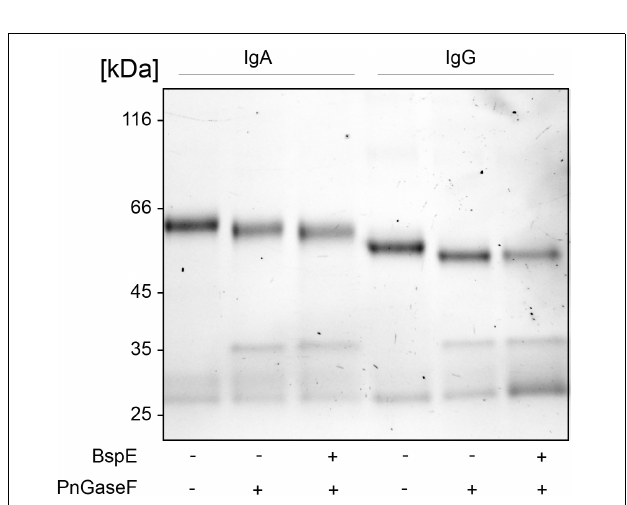
FIGURE 7 | Removal of N- glycosylation at position Asn 459 does not affect BspE hydrolysis of IgA. IgA control, IgA deglycosylated with PNGaseF (non-denaturing reaction conditions), IgA deglycosylated with PNGaseF followed by incubation with BspE were separated on a 10% SDS-PAGE. IgG verifies the activity of PNGaseF and the absence of BspE